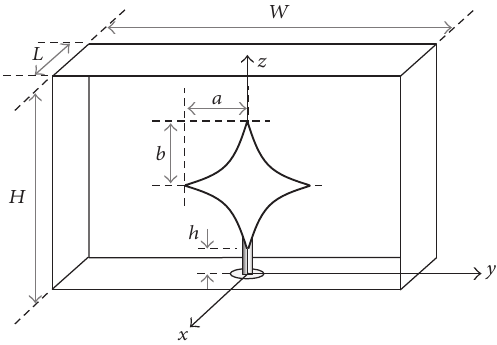
Figure 1: An antenna structure and its parameters.